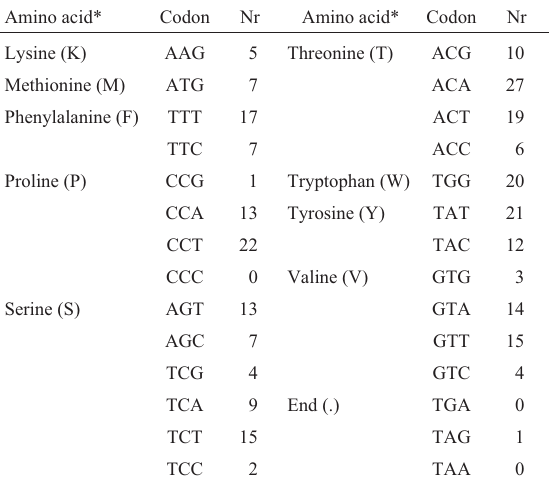
*Amino acid or punctuation one-letter code in parenthesis. Nr: Number of